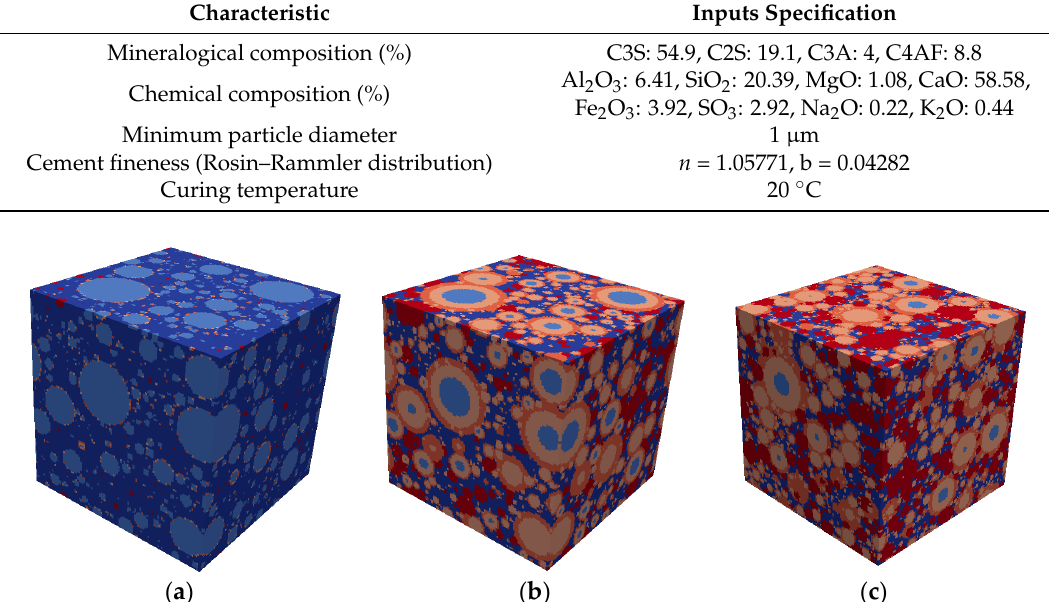
Table 1. Cement specifications.